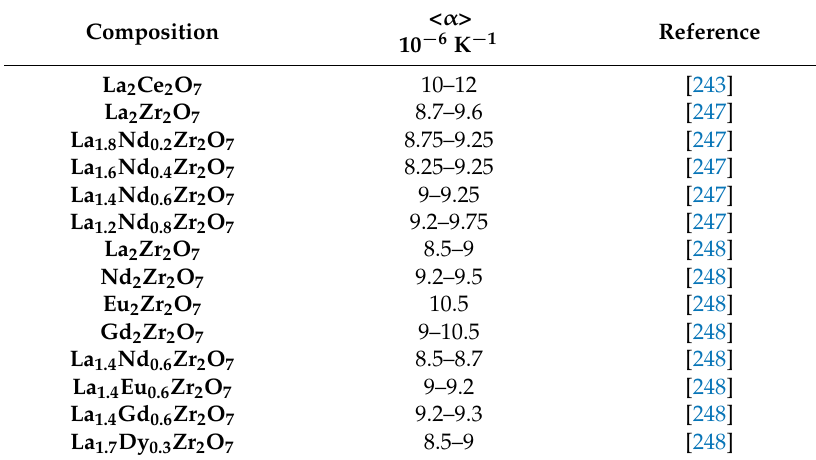
Table 6. Linear thermal expansion coefficients ( α ) for various A 2 B 2 O 7 oxides in the temperature range 400 to 1000 ◦